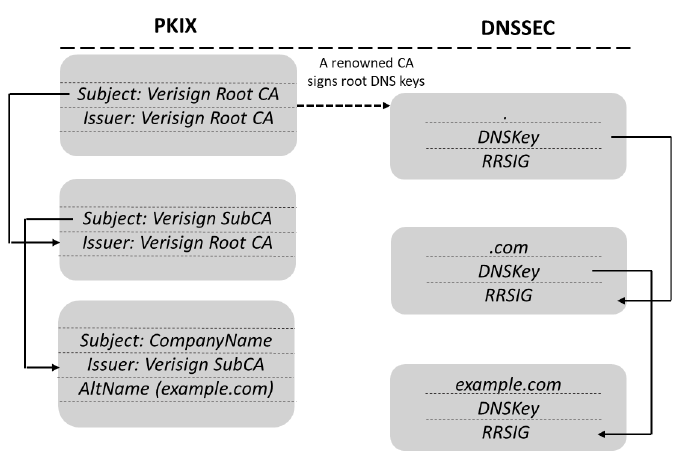
Figure 1. Comparison of verification chains in DNSSEC and PKIX. Image from